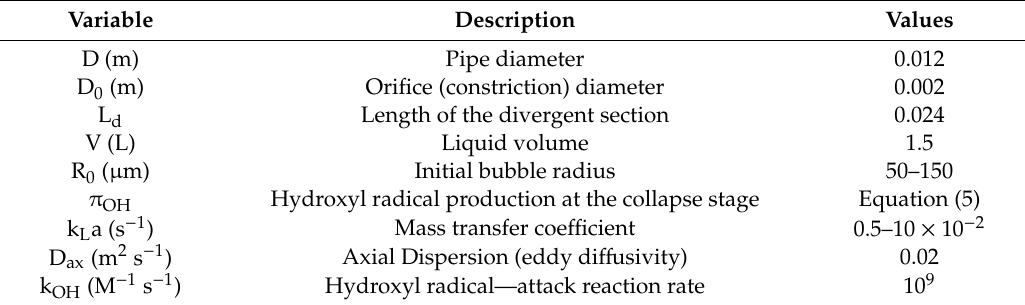
Table 2. Order of magnitude of the independent variables and main transport parameter for HC reactors (according to the experimental configuration of Ref. [39] and Ref. [51].